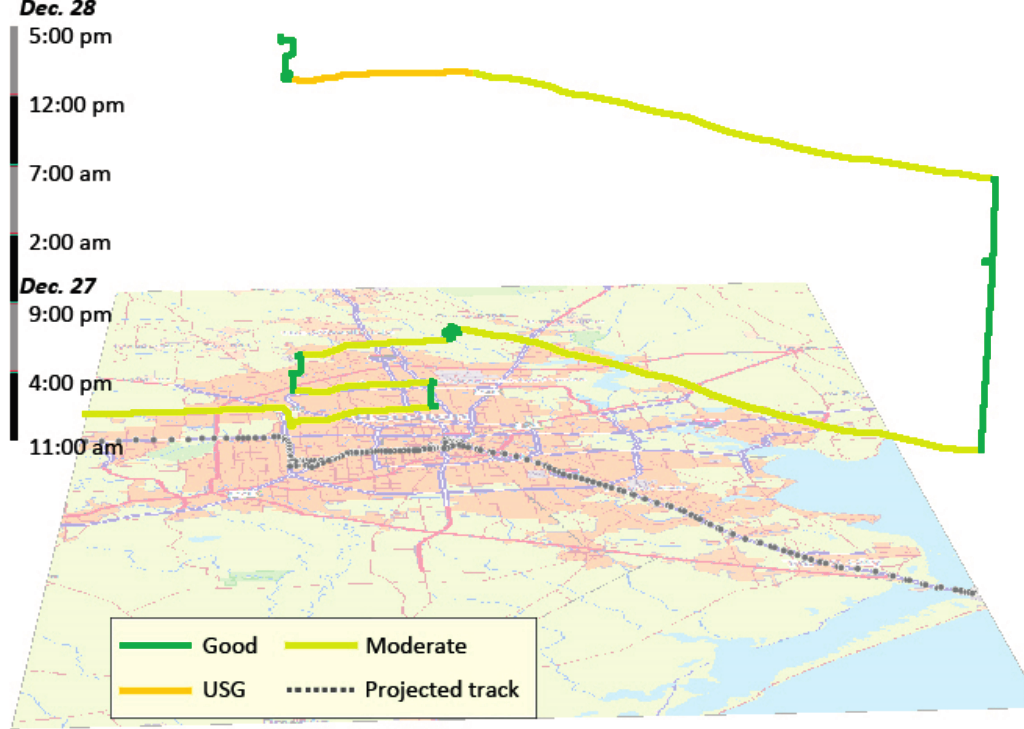
Figure 4. The volunteer’s space-time path with personal AQIs in Houston, Texas on 27 and 28 December